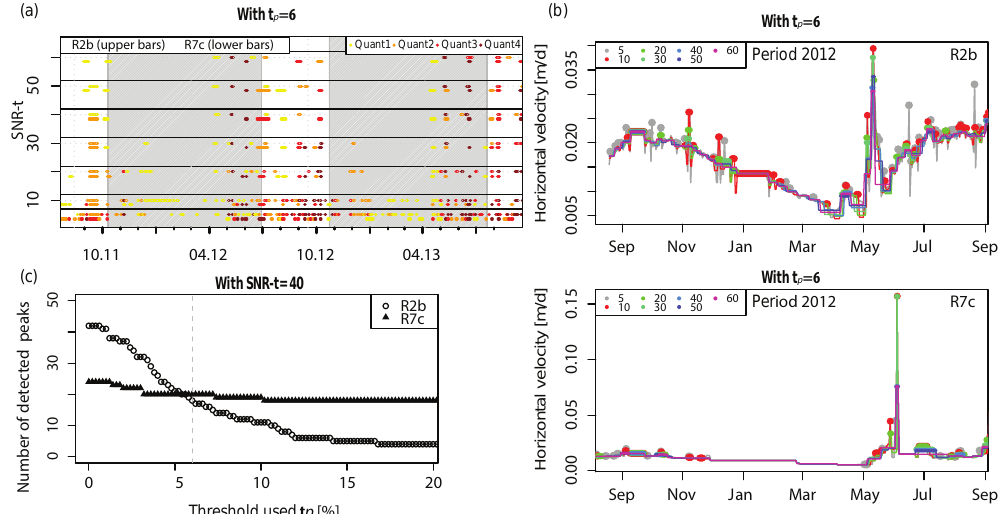
Figure 9. Detected peaks depend on the chosen SNR threshold (SNR-t) for velocity estimations and threshold ( t p ) for peak detection. Panel (a) : sensitivity of detected peaks for different SNR-t ( t p = 6%) for R2b and R7c. The colours refer to the strength of the peak (diff p ; the 25, 50, and 75% quantile of diff p ). The period with an insulating winter snow cover is shadowed in light grey. Panel (b) : estimated horizontal velocities and detected peaks (points) applying different SNR-t for R2b (upper) and R7c (lower). Panel (c) : sensitivity of the detected peaks for thresholds t p for R2b (points) and R7c (triangles). The x axis refers to different values applied for t p . In this study, we apply t p = 6 and SNR-t = 40.